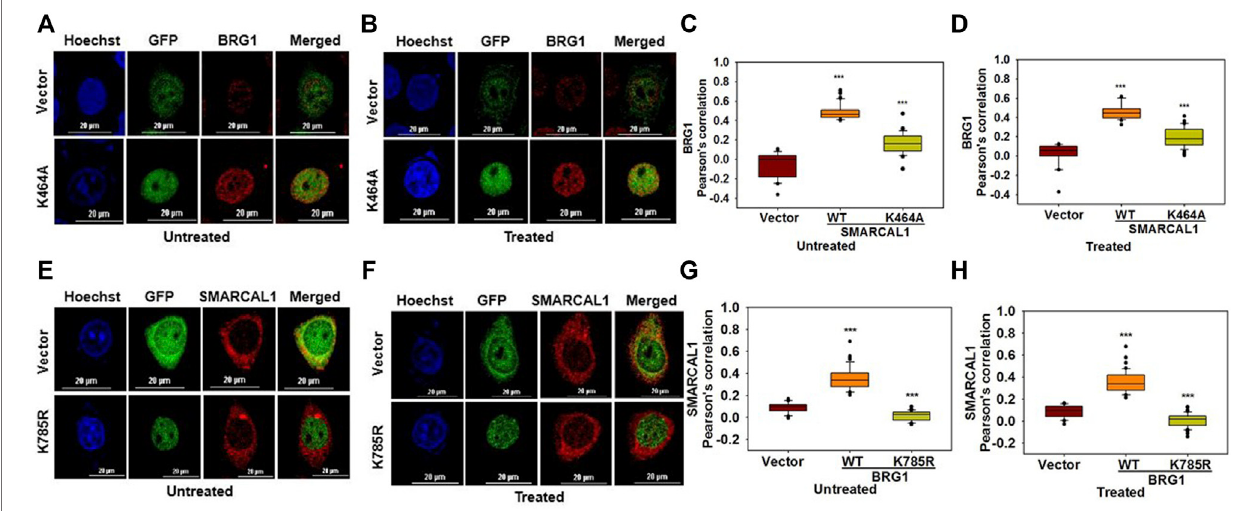
FIGURE 3 | The ATPase activity of SMARCAL1 and BRG1 is required for their co-localization (A) . Co-localization of GFP-SMARCAL1 K464A with BRG1 in the absence of doxorubicin treatment (B) . Co-localization of GFP-SMARCAL1 K464A with BRG1 in the presence of 2 μ M doxorubicin treatment for 10 min (C) . Pearson ’ s coef fi cient for the interaction in the absence of doxorubicin treatment (D) . Pearson ’ s coef fi cient for the interaction in the presence of doxorubicin treatment (E) . Co- localization of GFP-BRG1 K785R with SMARCAL1 in the absence of doxorubicin treatment (F) . Co-localization of GFP-BRG1 K785R with SMARCAL1 in the presence of 2 μ M doxorubicin treatment for 10 min (G) . Pearson ’ s coef fi cient for the interaction in the absence of DNA damage (H) Pearson ’ s coef fi cient for the interaction in the presence of DNA damage. In all these experiments, HeLa cells were treated with 2 μ M doxorubicin for 10 min and n ≥ 40 cells for GFP-SMARCAL1 K464A and BRG1 and n ≥ 60cells for GFP-BRG1 K785R and SMARCAL1 were analyzed. Star indicates signi fi cance with * p -value < 0.05, ** p -value < 0.005, *** p value < 0.0001. The wild-type data used in the analysis has been shown in Figure 2 The scale in the images is 20 μ